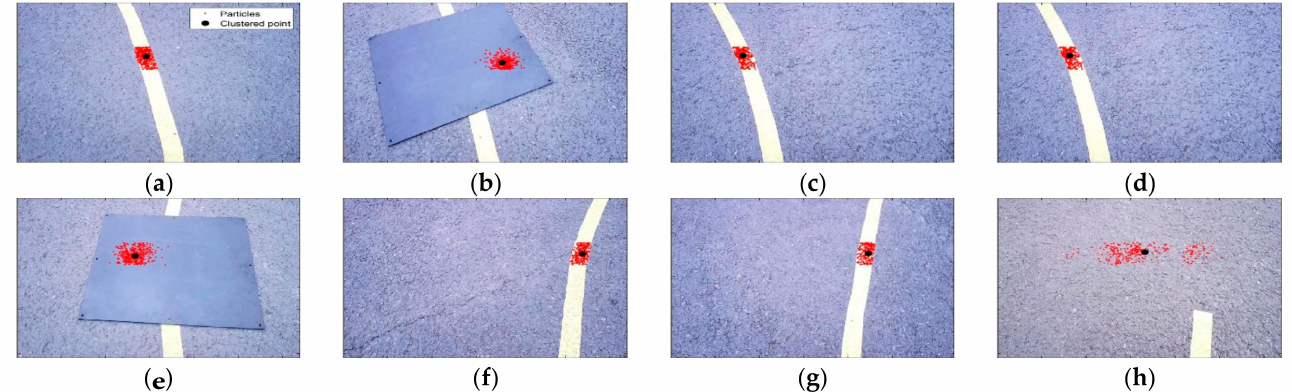
Figure 16. ( a ) Actual experiment image—22nd frame; ( b ) actual experiment image—58th frame; ( c ) actual experiment image—100th frame; ( d ) actual experiment image—150th frame; ( e ) actual experiment image—178th frame; ( f ) actual experiment image—230th frame; ( g ) actual experiment image –300th frame; ( h ) actual experiment image—360th frame.